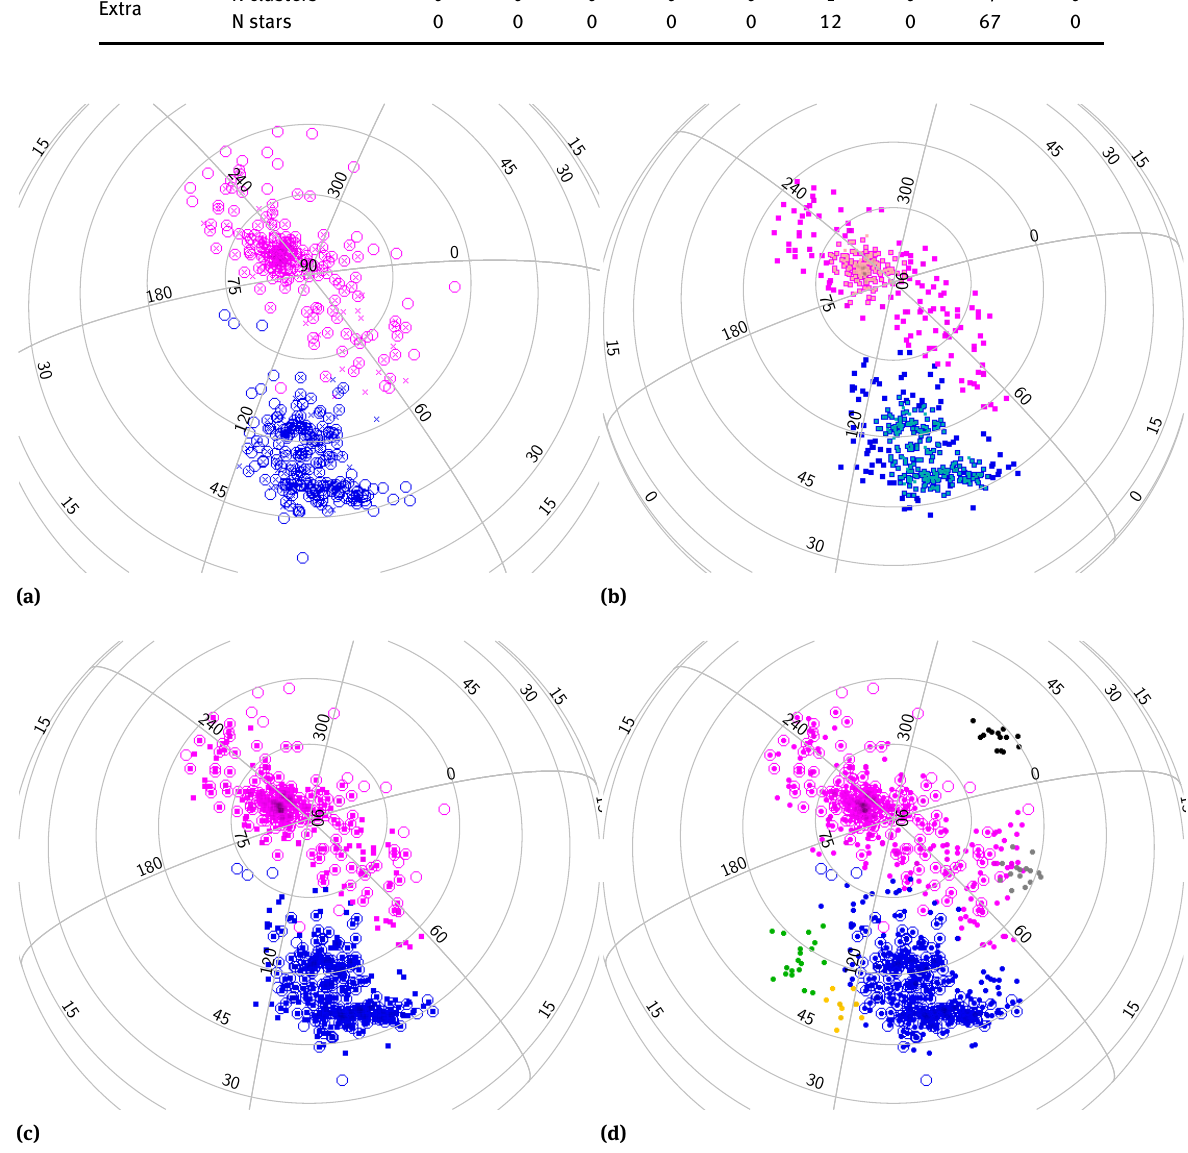
Figure 5. Comparison of number and distribution of sources considered as probable members of Coma Ber cluster (magenta) and of Group X (blue) obtained by different methods. The coordinate frame is Galactic (l,b). Left upper plane – samples from Fürnkranz et al. (2019) (crosses) vs Tang et al. (2019) (empty circles). The upper right plane – sample (12,1) (filled squares) vs sample I (clustering of single stars, small dots of lighter colours). The middle plane – sample (12,1) (filled squares and empty squares for small clusters, see discussion in the text) vs sample from Tang et al. (2019) (empty circles). Lower plane – sample (12,2) (filled dots) vs sample from Tang et al. (2019) (empty circles). Black, grey, yellow, green dots – clustered stars not identified with known structures with